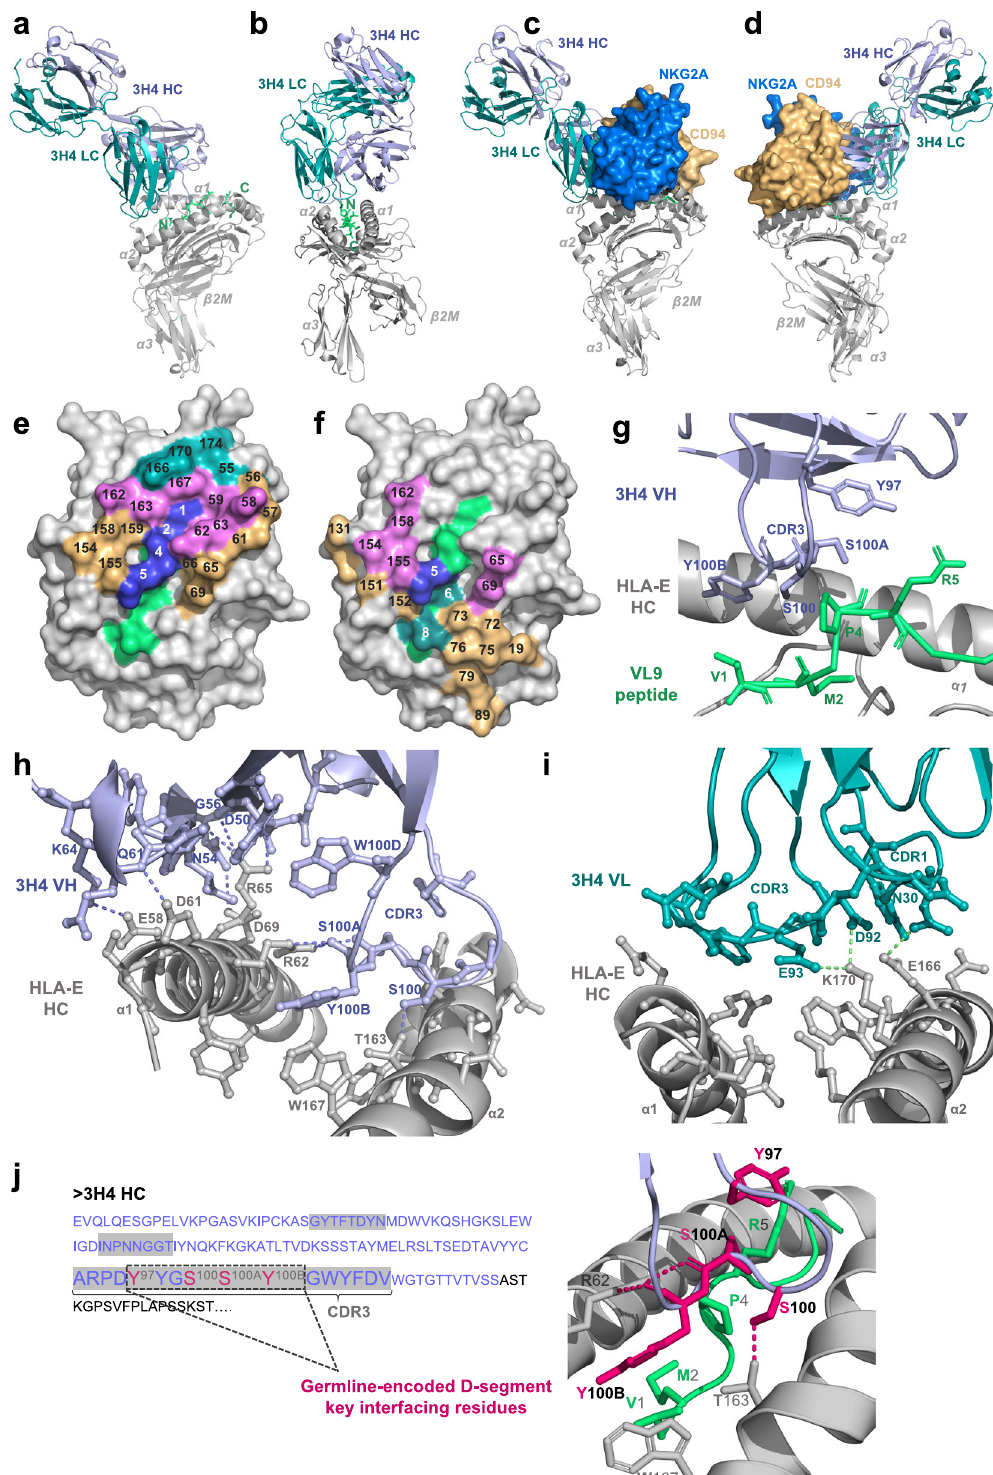
fl uorescently labeled HLA-E-VL9 tetramer (Fig. 4c). Eleven 3H4 variants were selected for experimental characterization as recombinant human IgGs from the highly represented clones remaining in the library upon the fi nal selection round. These novel Abs (3H4 Gv1 to 3H4 Gv12) were mutated at positions 97- 100 of the CDR H3 loop. Compared to the original 3H4 mAb, the optimized antibodies predominantly contained small amino acids at positions 97 and 98, a polar amino acid at position 99, and a